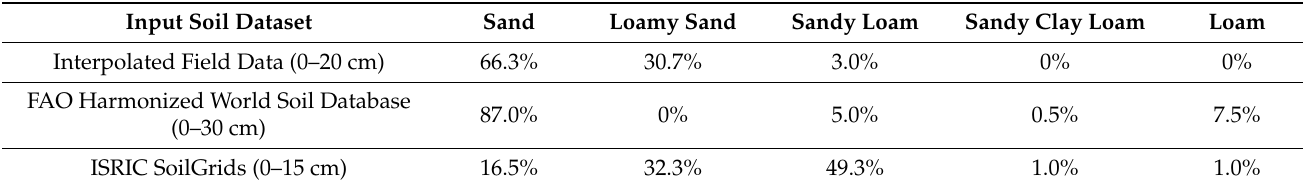
Table 6. Breakdown of topsoil textures in each